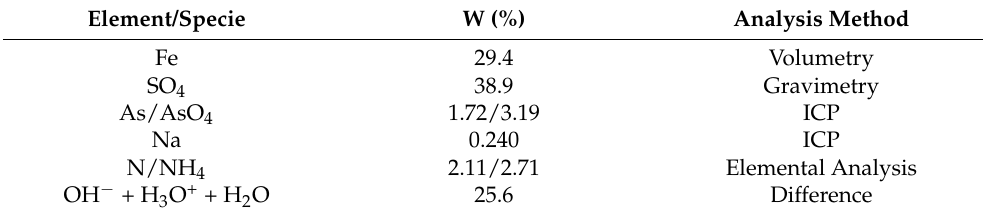
Table 3. Chemical composition of the obtained jarosite. Element/Specie